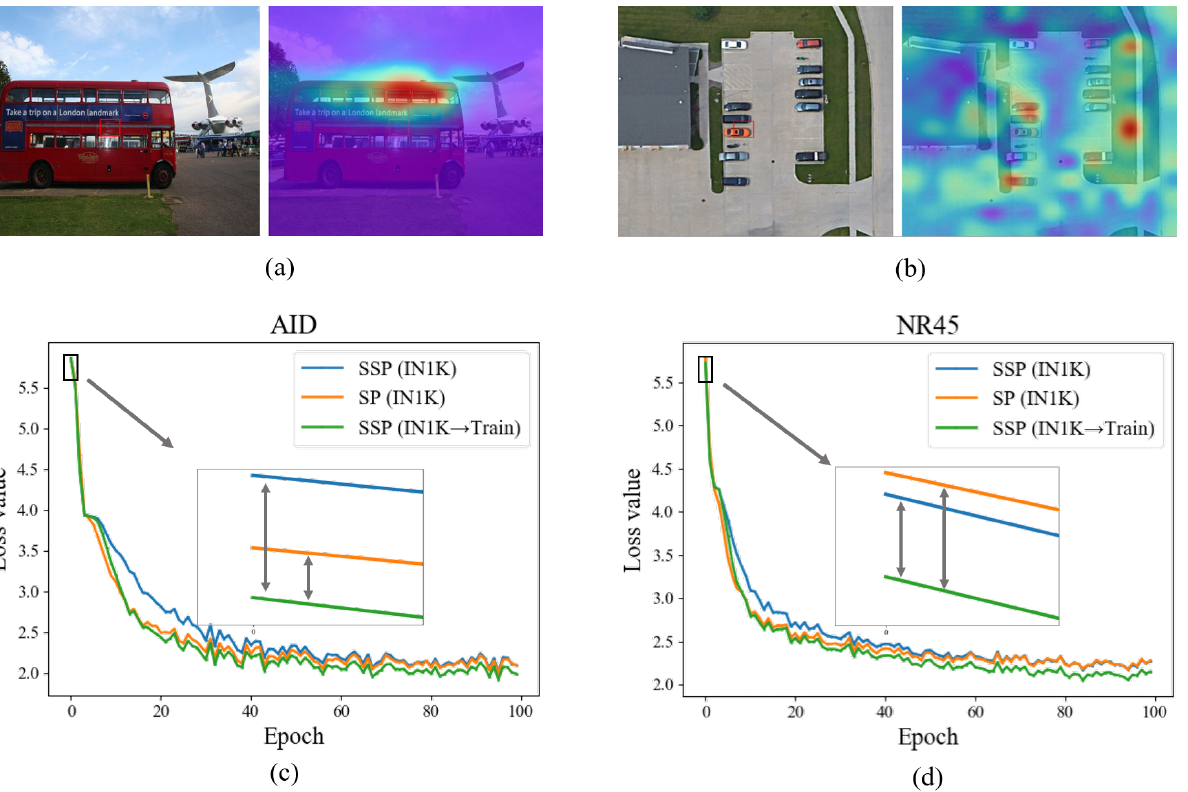
Figure 3. The analysis of domain gap and transfer ability from nature scene to RSD. ( a ) is the self- attention map for a vehicle of natural scene image; ( b ) is the self-attention map for the vehicles of remote sensing scene image; ( c , d ) represent the fine-tuning loss convergence curves of different pre-training methods on AID [19] and NR45